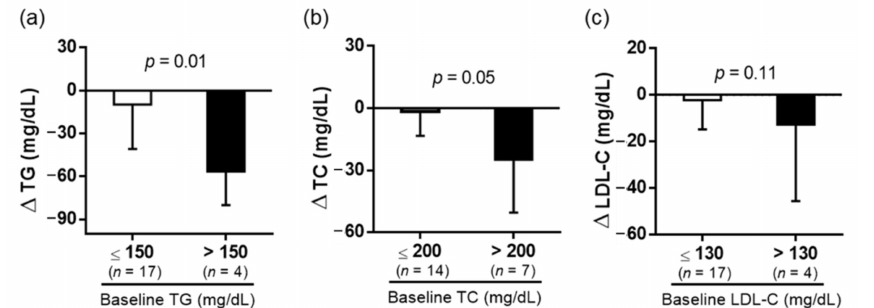
Figure 2. Subgroup analysis according to the baseline TG, TC, and LDL-C levels. Change of ( a ) TG ( b ) TC and ( c ) LDL-C in different subgroups. Values are presented as mean ± SD. Unpaired t -test was used to compare the means of baseline and end-of-the study measurements. Significant differences: p < 0.05. TC, total cholesterol; TG, triglycerides; and LDL-C, low-density lipoprotein cholesterol.